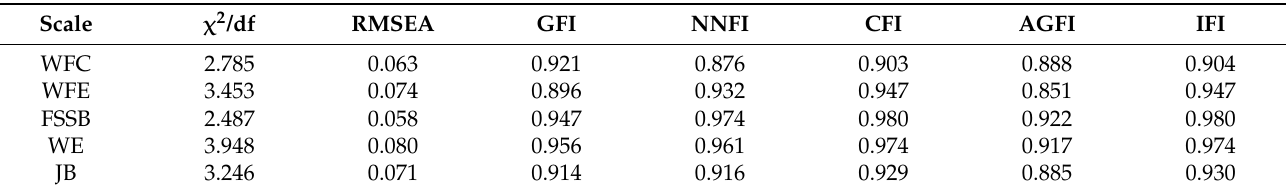
Table 4. Fitting indicators of structural equation model.